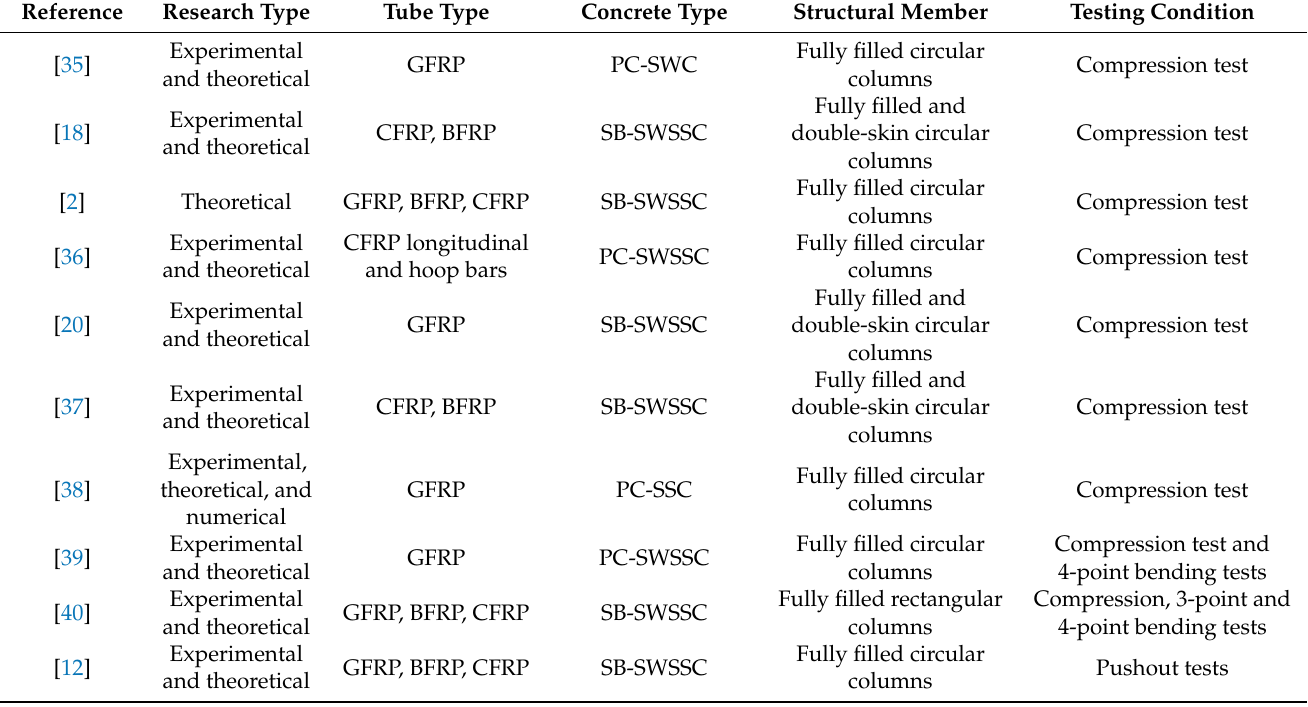
Table 1. Research studies on short-term structural behaviour of SWSSC filled FRP tubes adopted from [22], with permission from Elsevier,